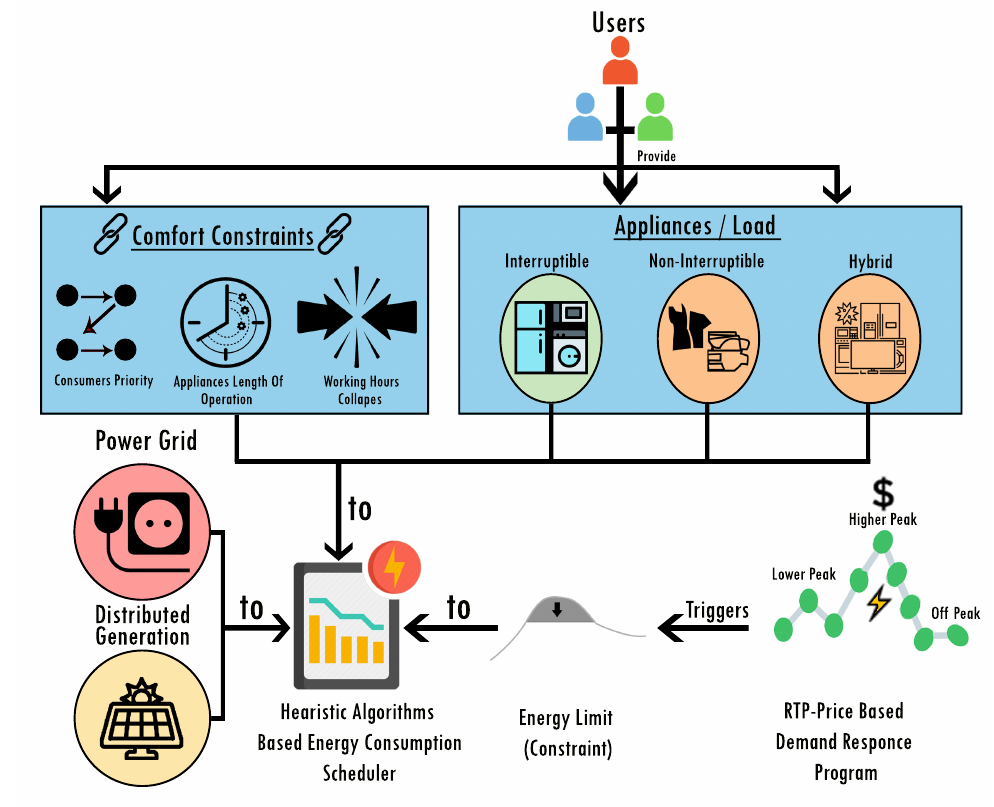
Figure 1. Developed system